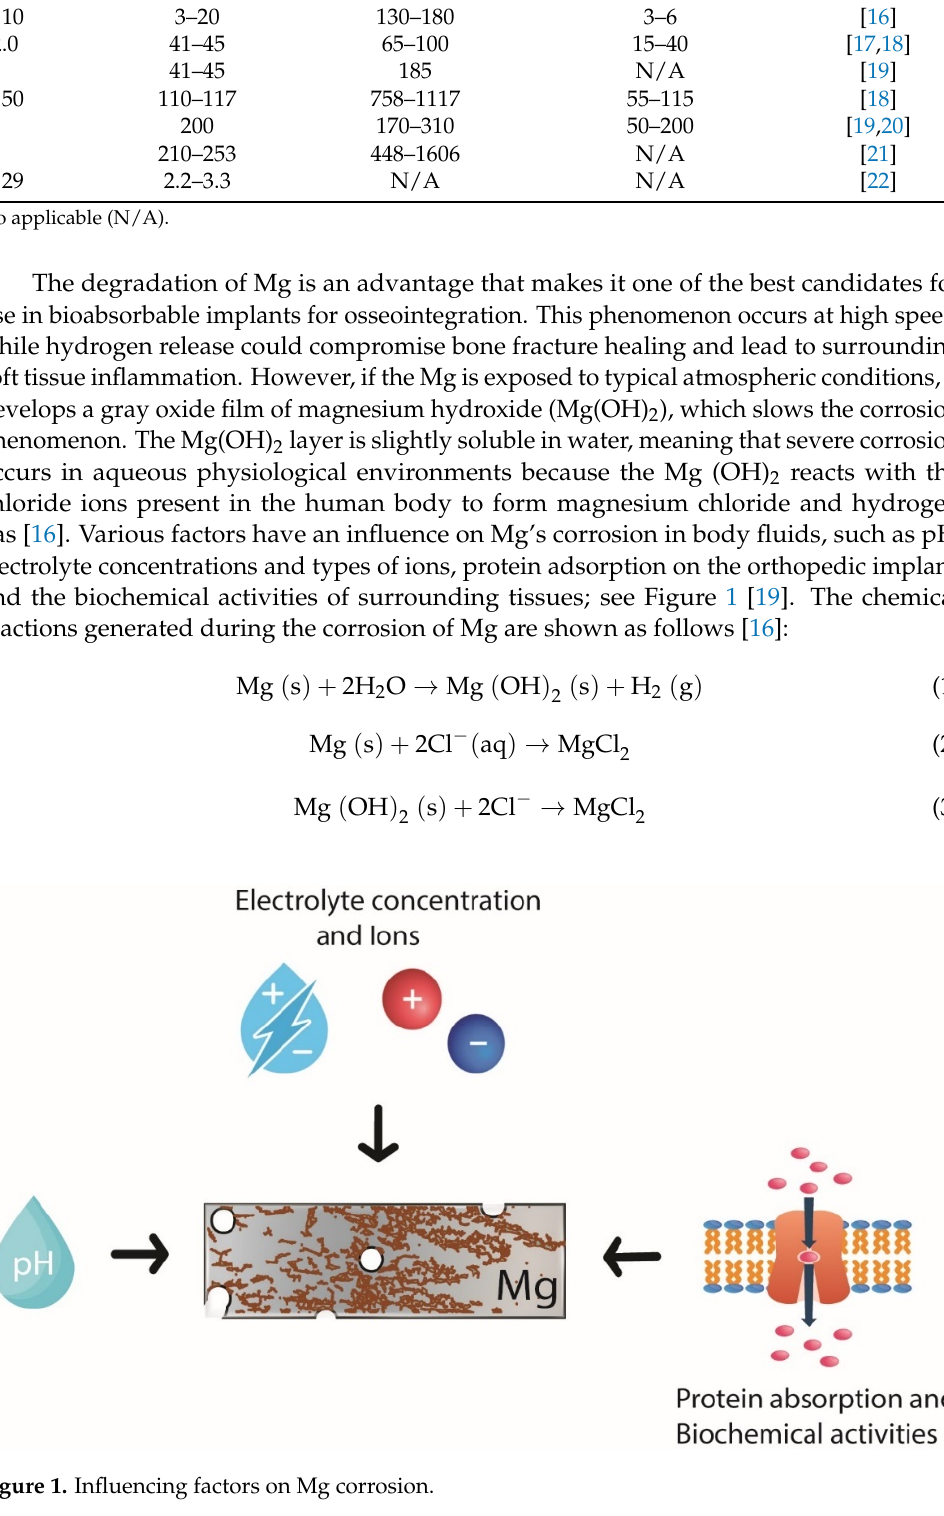
Table 1. Physical and mechanical properties of the main metals used for implants in comparison to natural bone.